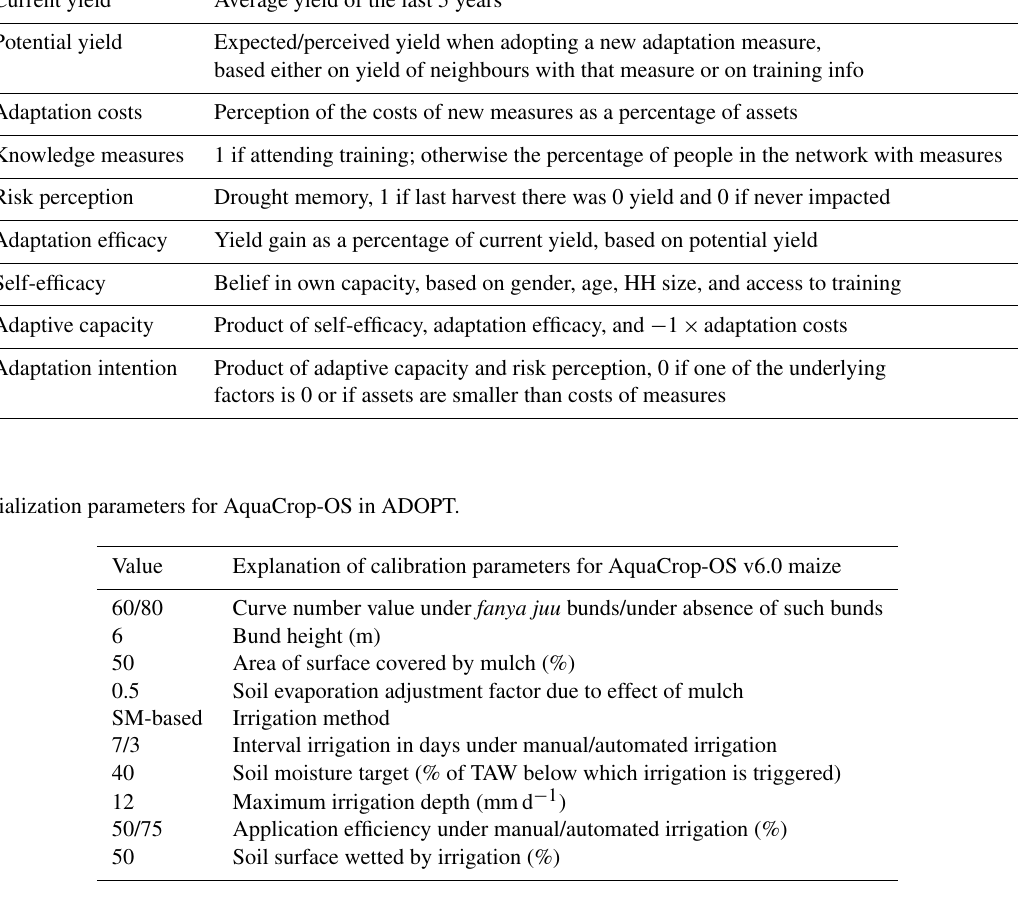
Table A2. Initialization parameters for the behavioural module in ADOPT. Factor Explanation of the PMT factors Current yield Average yield of the last 5 years